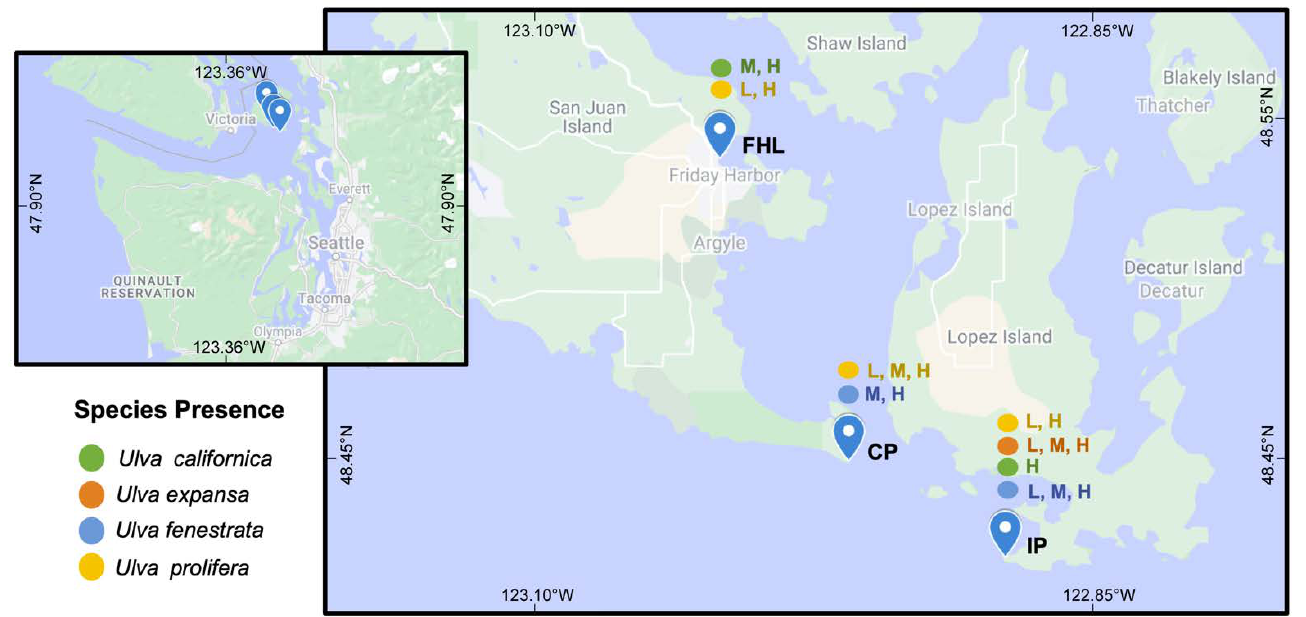
Figure 2. Map showing the distribution of blade-form Ulva species collected from different intertidal heights at three San Juan Island sites that experience different wave exposures. Species are indicated by color and intertidal zones by letters: L = low; M = middle; H = high. Locations: FHL = Friday harbor Laboratory beach front; CP = Cattle Point; IP = Iceberg